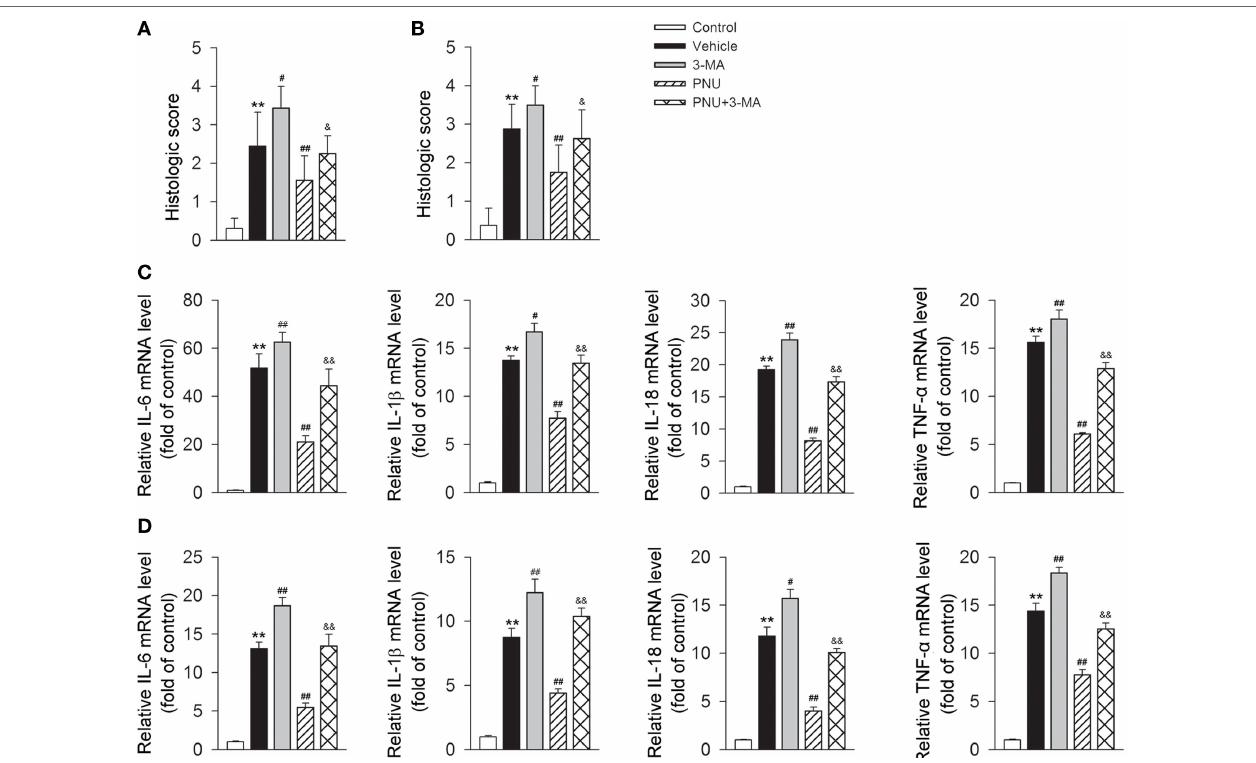
FigUre 4 | Blockade of autophagy using 3-methyladenine (3-Ma) attenuates the alleviative effects of α 7nachr activation on severity and inflammatory response in experimental autoimmune encephalomyelitis (eae) mice . EAE mouse model was created. PNU282987 (0.1 mg/kg, i.p.) was given for the activation of α 7nAChR and 3-MA (10 mg/kg, i.p.) was given for the blockade of autophagy process in vivo . Spinal cord and spleen were isolated from mice on day 17 postimmunization. (a) Quantitative analysis of hematoxylin and eosin staining for the testing of the extent of spinal inflammatory infiltration ( n = 8 per group). ** P < 0.01 vs control, # P < 0.05 vs Veh, ## P < 0.01 vs Veh, & P < 0.05 vs PNU. (B) Quantitative analysis of luxol fast blue staining for the testing of the extent of spinal demyelination ( n = 8 per group). ** P < 0.01 vs control, ## P < 0.01 vs Veh, ## P < 0.01 vs Veh, & P < 0.05 vs PNU. Production of IL-6, IL-1 β , IL-18, and tumor necrosis